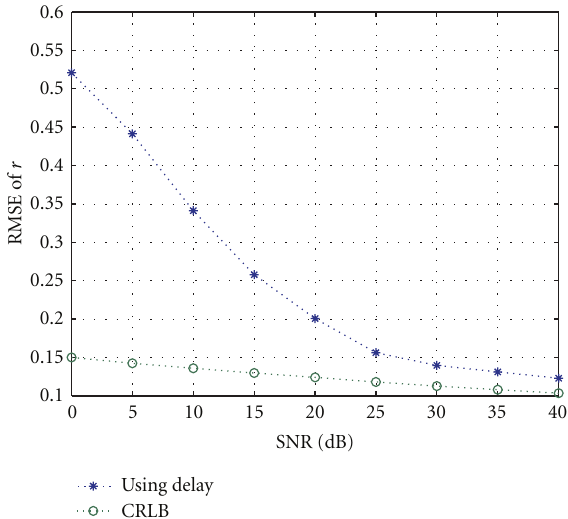
Figure 16: Performance of range estimation using cross-correlation based time-delay estimation